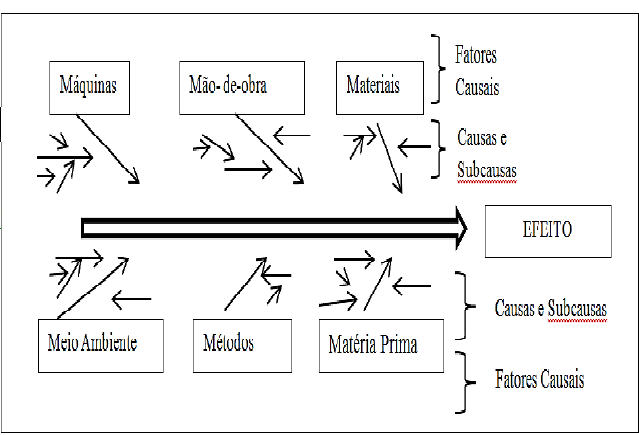
Figura 1: Representação do diagrama de Ishikawa Fonte: Adaptado [9].